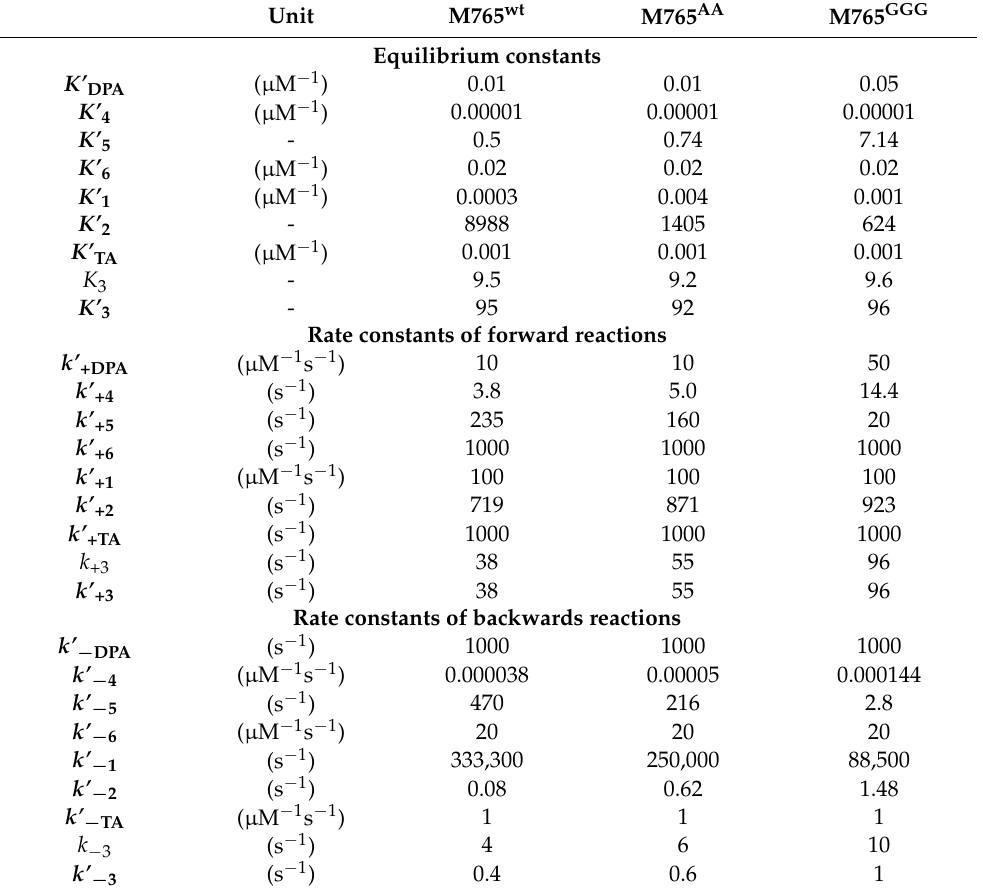
Table 5. Parameters used for the estimation of the fractional occupancies of intermediate states.